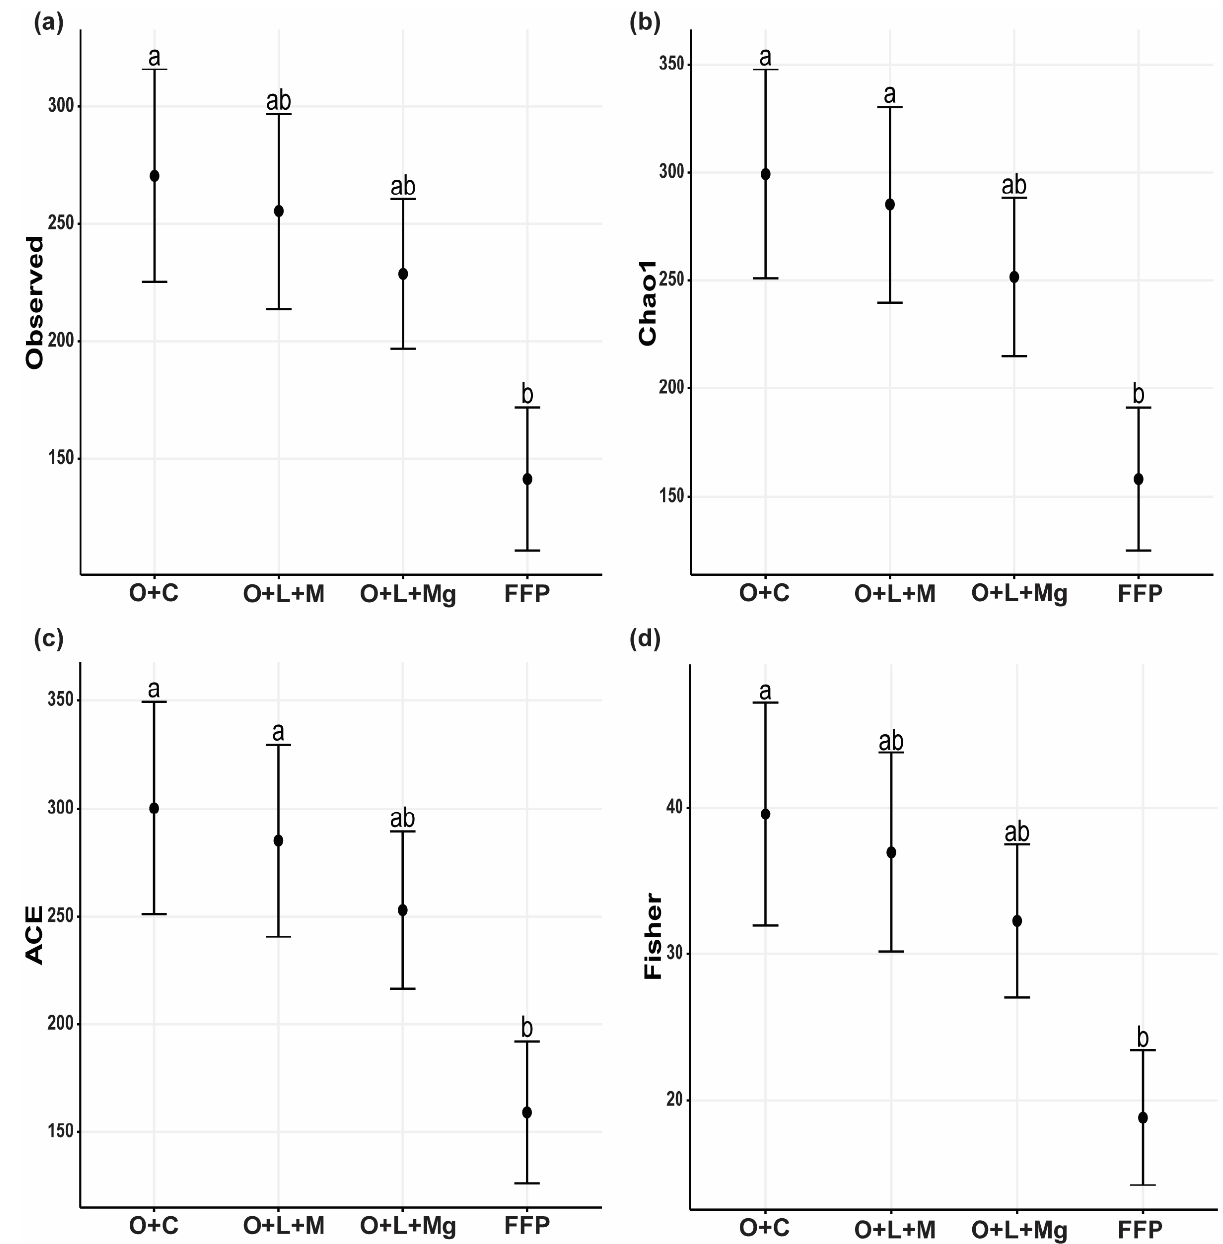
Figure 3. The alpha diversity indices of soil fungal communities. The different α -diversity indices calculated among different treatments: ( a ) observed; ( b ) Chao1; ( c ) ACE; ( d ) Fisher. The different lowercase letters indicate significant differences ( p < 0.05) among different treatments.